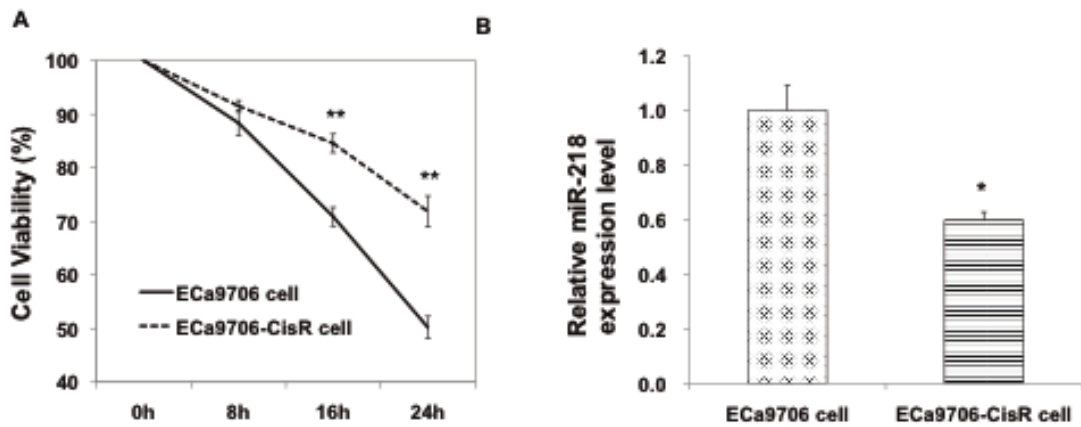
Figure 1. Expression of miR-218 is lower in cisplatin-resistant esophageal cancer cell lines. (A) Cell viability inhibition effect of 5 m M cisplatin on ECa9706 cells and ECa9706-CisR cells. **: P<0.01. (B) Relative miR-218 expression level in ECa9706 cells and ECa9706-CisR cells. *: